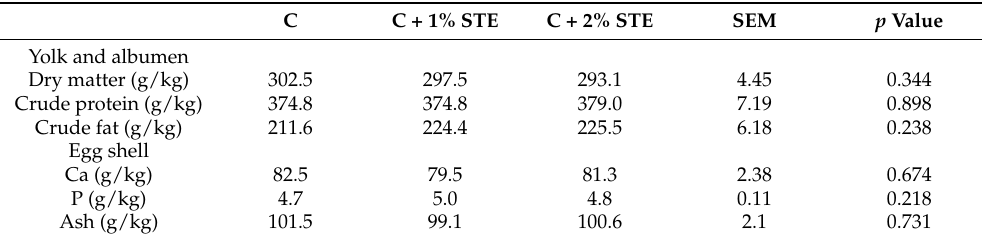
Table 4. Proximate analysis of the yolk and albumen and mineral analysis of the eggshell after feeding dried stevia leaves to laying hens for four